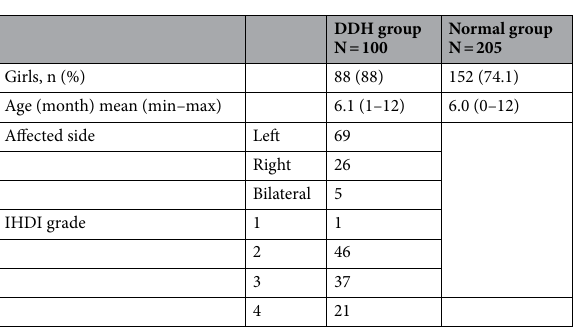
Table 1. Basic characteristics. DDH Developmental dysplasia of the hip, IDHI International Hip Dysplasia